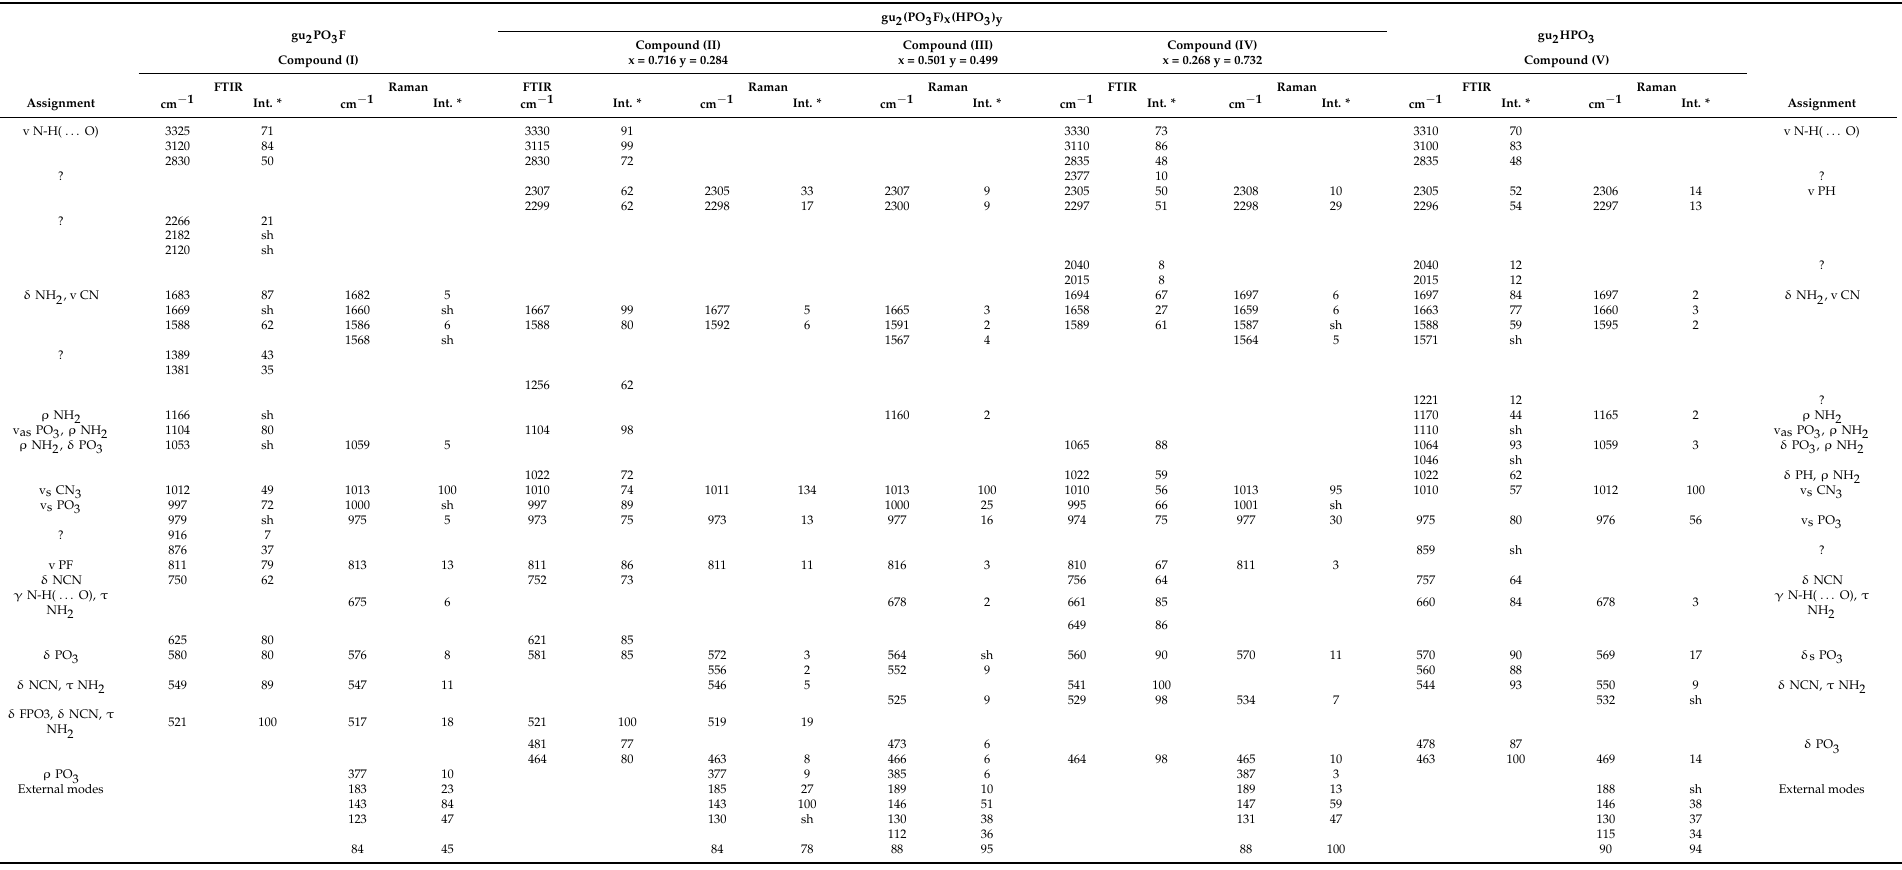
Table 5. FTIR and Raman spectra of compounds ( I )–( V